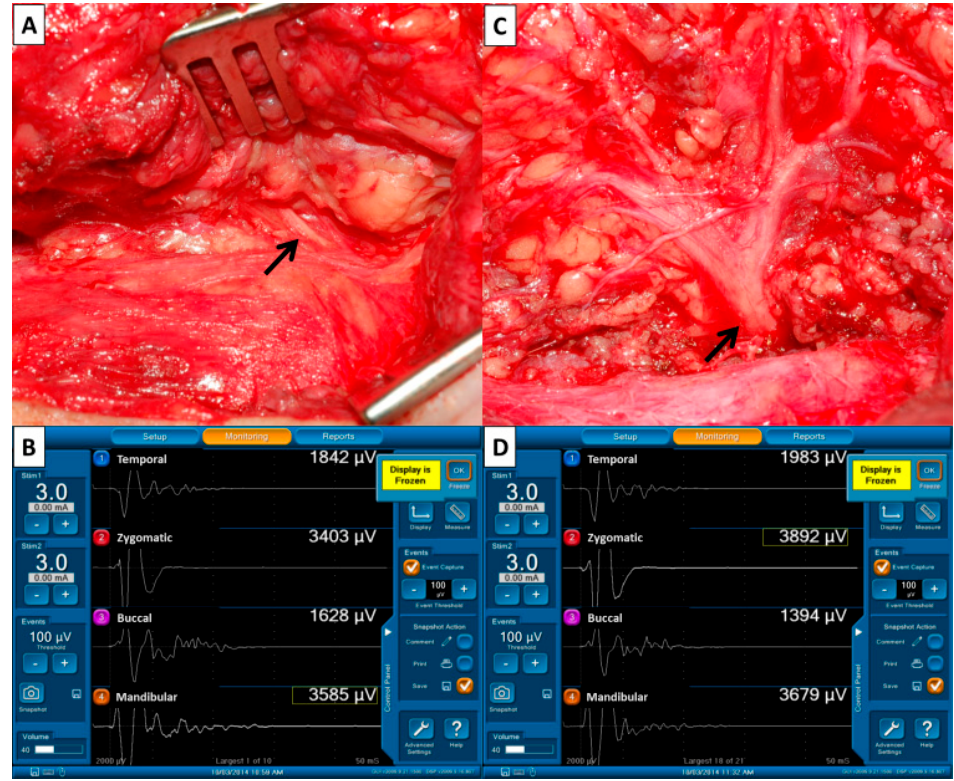
Figure 2. Pre- and post-dissection facial nerve (FN) signals to evaluate FN function. ( A ) The FN trunk ( ↑ ) was first identified during parotid gland dissection and we performed supramaximal stimulation of the trunk using 3–5 mA. ( B ) The four elicited EMG signals representing the function of FN branches were displayed on the monitoring screen. The four EMG signals were defined as F 1 signals and were used as basic reference data before dissection of the FN branches. ( C ) The stimulus current (3–5 mA) was applied to the FN trunk ( ↑ ) after dissecting the FN branches and resecting the parotid tumor. ( D ) The four elicited EMG signals were defined as F 2 signals. The EMG amplitudes on each channel of F 1 and F 2 signals were compared.